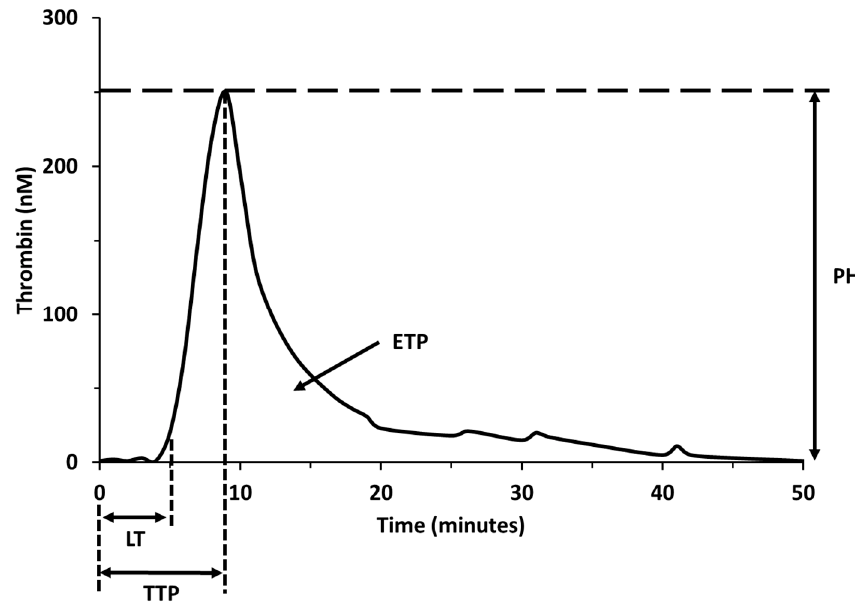
Figure 1. Quantitative parameters of thrombin generation. Lag time (LT); time to peak (TTP); thrombin peak height (PH); area under the thrombin curve or endogenous thrombin potential (ETP).